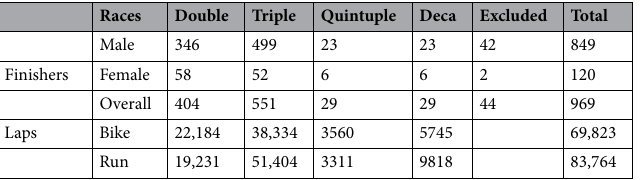
Table 1. Number of finishers for each race type and number of excluded finishers.